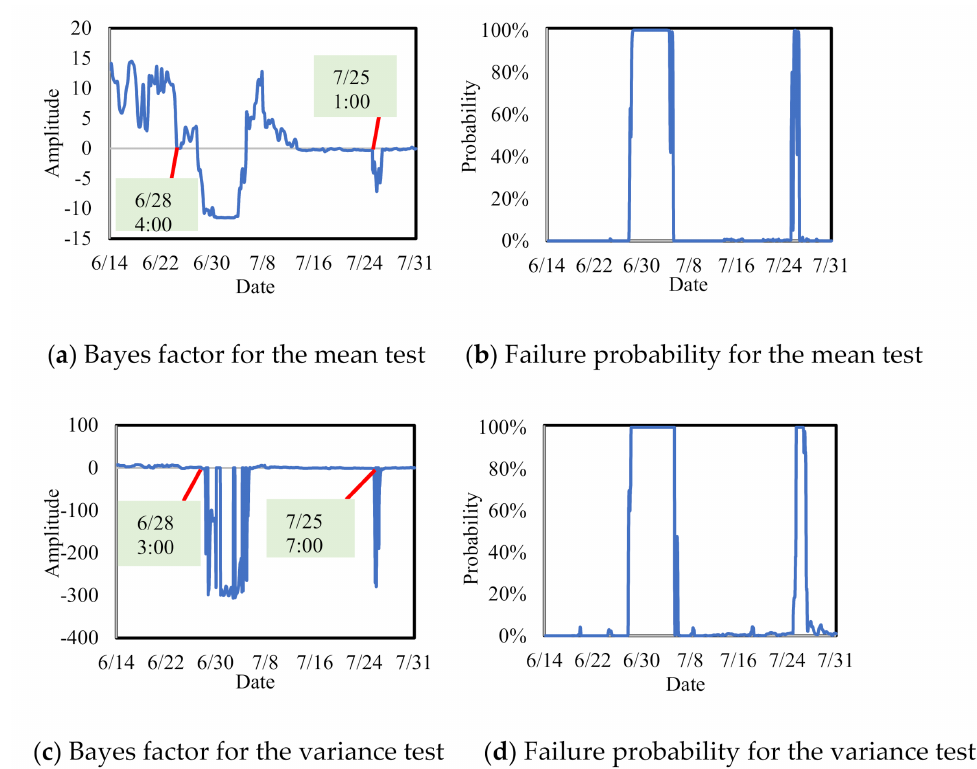
Figure 10. Bayes factor and probability of